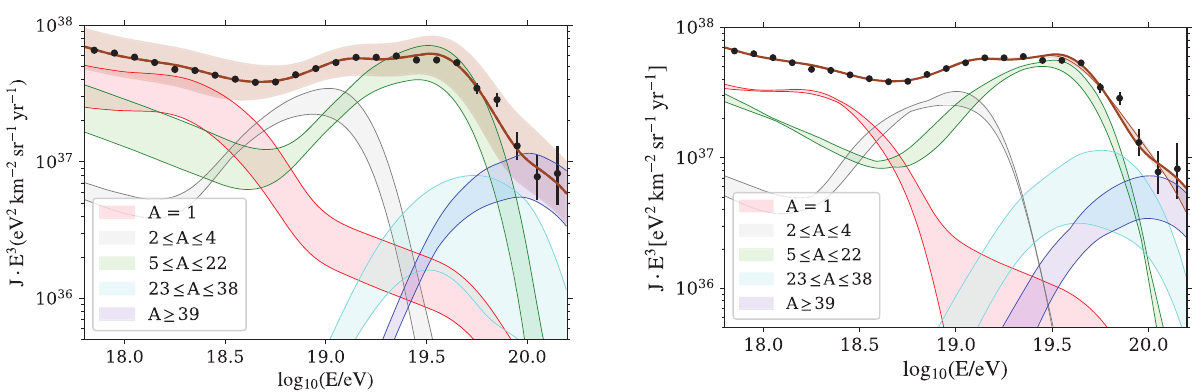
Figure 4. The combined e ff ect of the experimental uncertainties ( left ) and of the uncertainties from models ( right ) on the all-particle energy spectrum and on the partial contributions of the di ff erent mass groups at Earth.